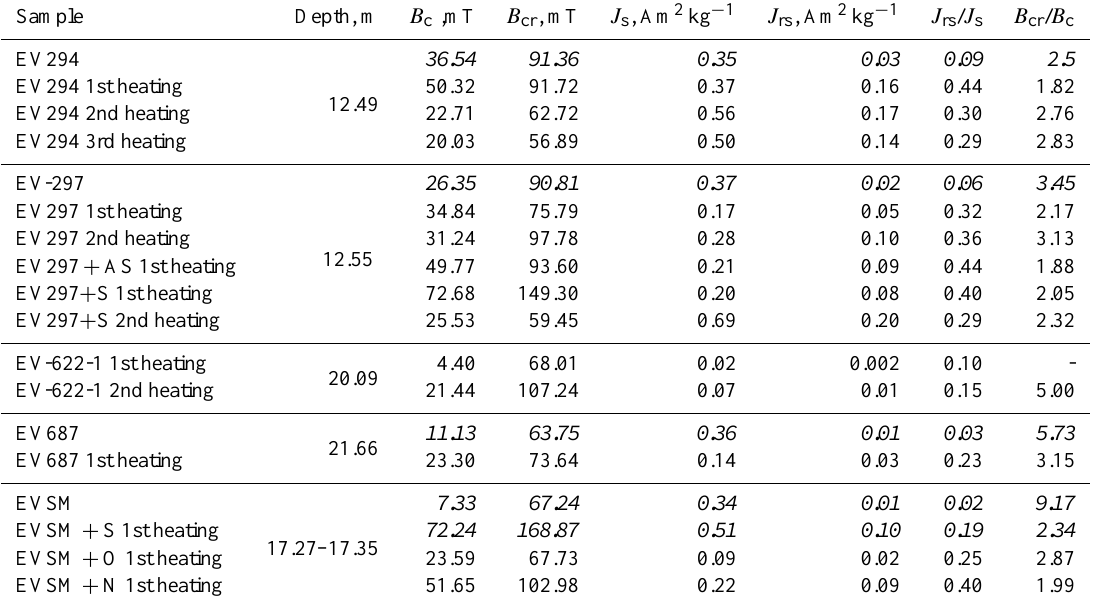
Table 4. Hysteresis parameters of vivianite nodules. Sample